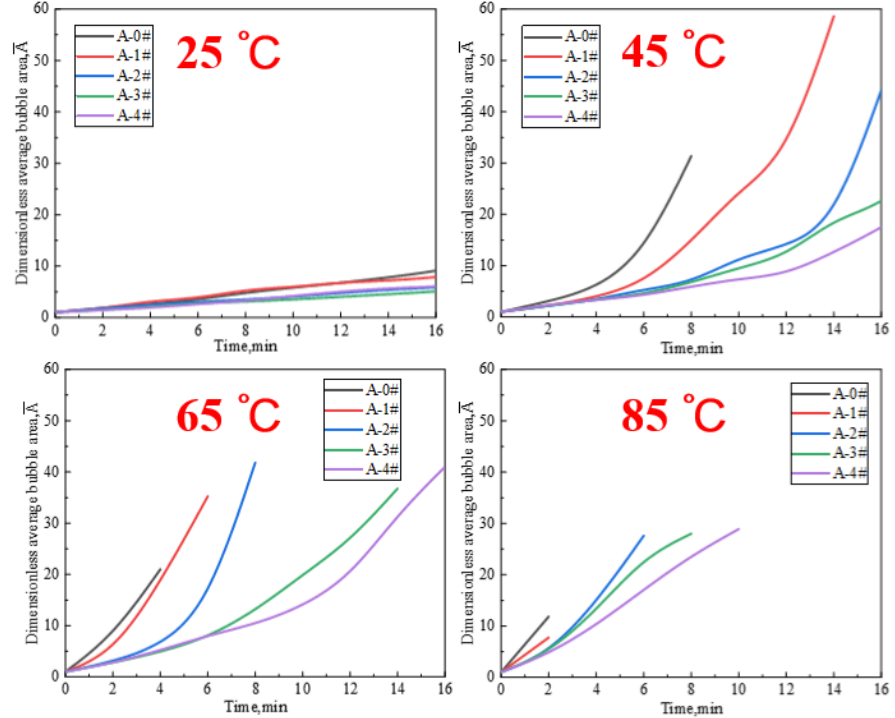
Figure 8. Variation of uncaused mean foam numbers in mixed dispersions at different temperatures with time.